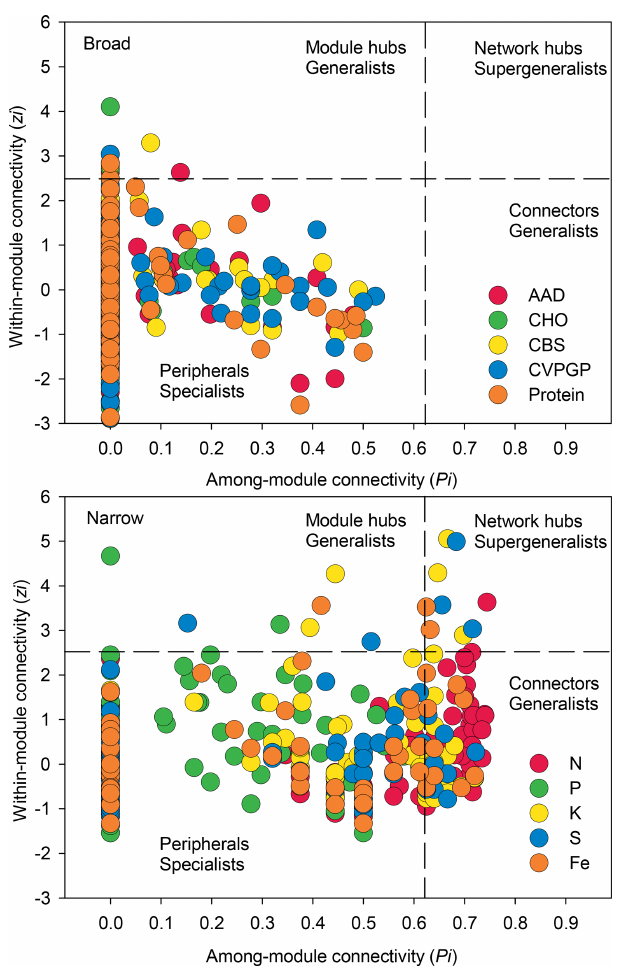
Figure 5. Network information on taxonomic compositions for broad and narrow functions. The figure shows node distributions of module-based topological roles of taxonomic compositions for broad and narrow functions determined by scatter plots of within- module connectivity ( Z i ) versus among-module connectivity ( P i ). The threshold values of Z i and P i for categorization were 2.5 and 0.62,